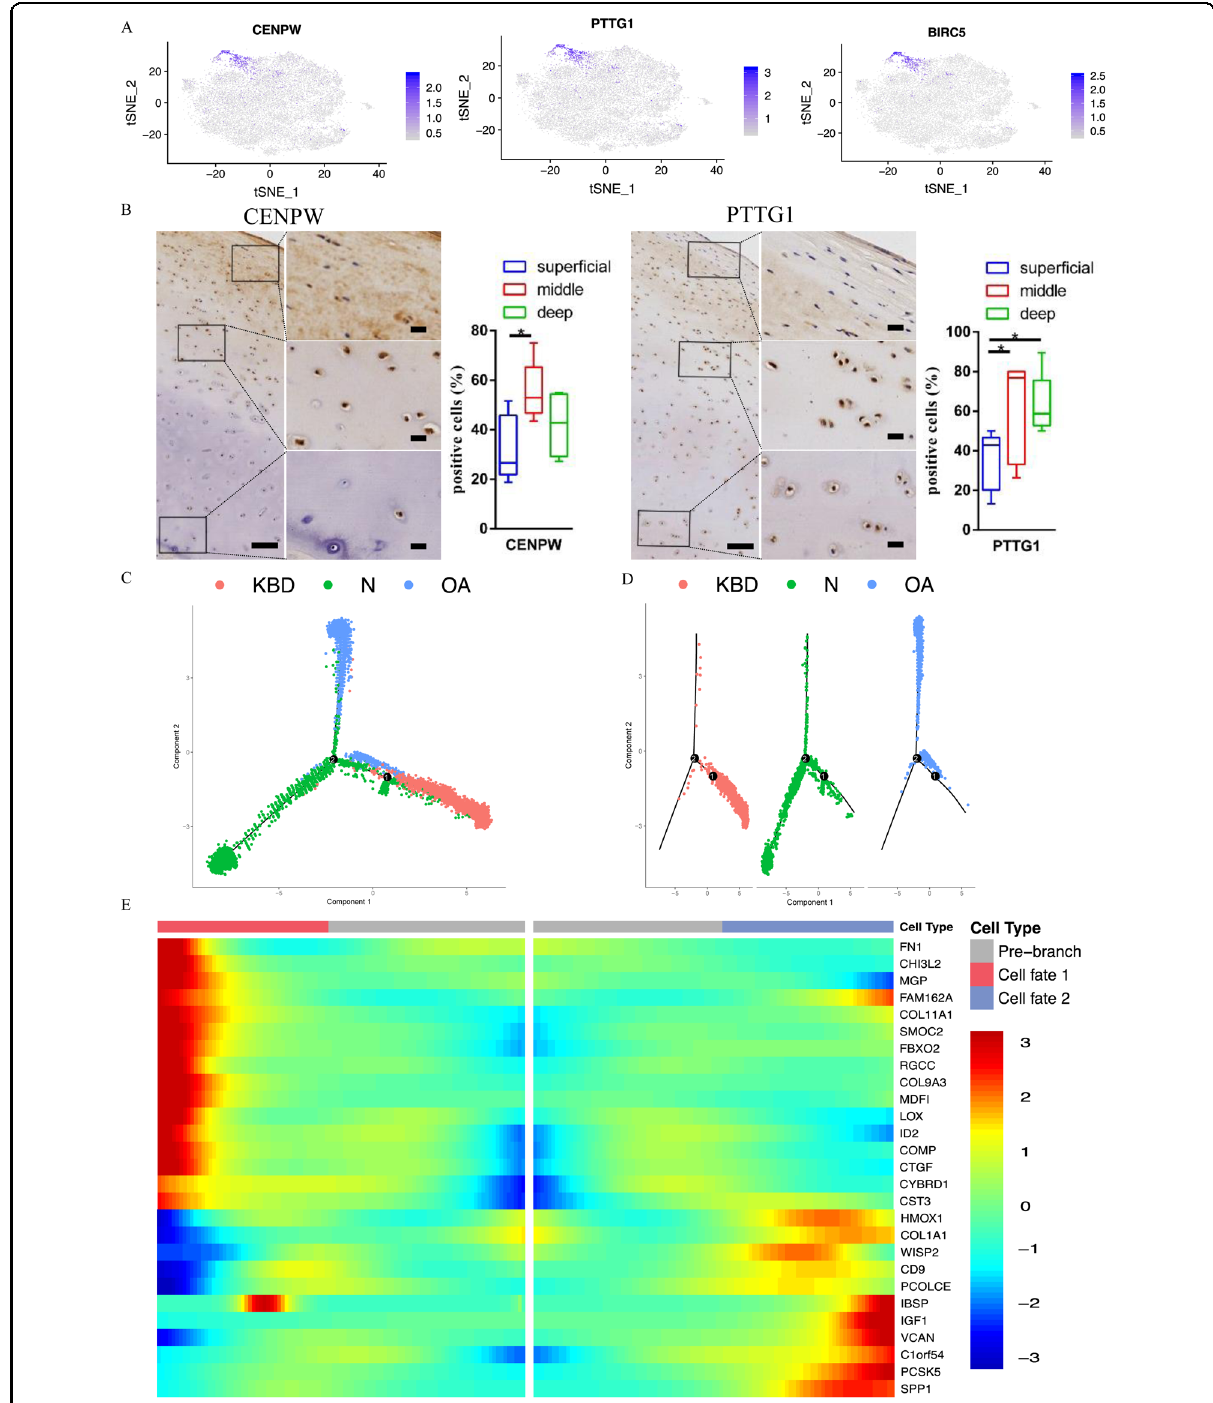
Fig. 4 Single-cell RNA-sequencing analysis of the cell population in healthy controls. A Gene expression plots of CENPW, PTTG1 and BIRC5. Dot colour corresponds to the level of gene expression in each cell. t-SNE, t-distributed stochastic neighbour embedding. B Representative immunohistochemistry staining of CENPW and PTTG1 in healthy cartilage tissues. Scale bar, left, 500 μ m; right, 50 μ m, and quanti fi cation of positive cells of different areas (up, middle, deep) in healthy cartilage tissues displayed by box plot ( n = 5). * p < 0.05. C , D Monocle pseudotime trajectory showing the progression of KBD, OA and the control. E The expression of the genes in a branch-dependent manner. Each row indicates the standardised kinetic curves of a gene. The centre of the heatmap shows the kinetic curve value at the root of the trajectory. From the centre to the left of the heatmap, the kinetic curve progresses from the root along the trajectory to fate 1. Starting from the right, the curve from the root to fate